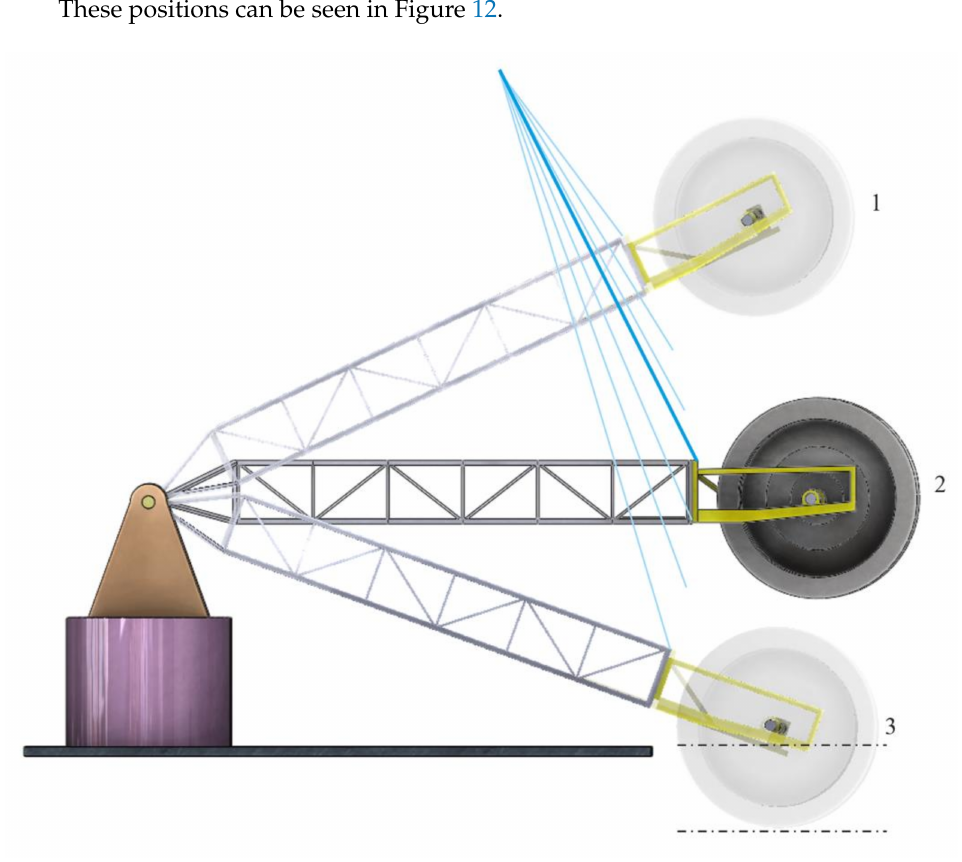
Figure 12. Positions of the BWE boom for which the frequency response analysis is performed: (1) the maximum height excavation position (25 ◦ ), (2) the horizontal excavation position (0 ◦ ), and (3) the lowest possible excavation position, under the bench ( − 20 ◦